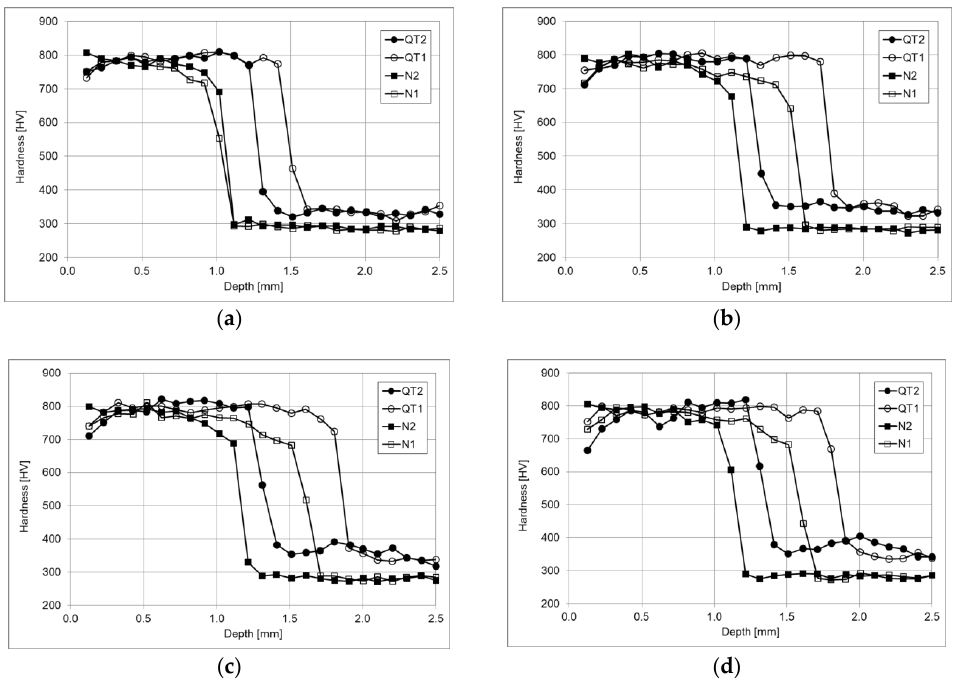
Figure 4. Comparison of measured hardness values vs. depth on the YZ symmetry plane for four different analyzed cases at Y : ( a ) 18.5 mm; ( b ) 35.0 mm; ( c ) 60.0 mm; and ( d ) 80.0